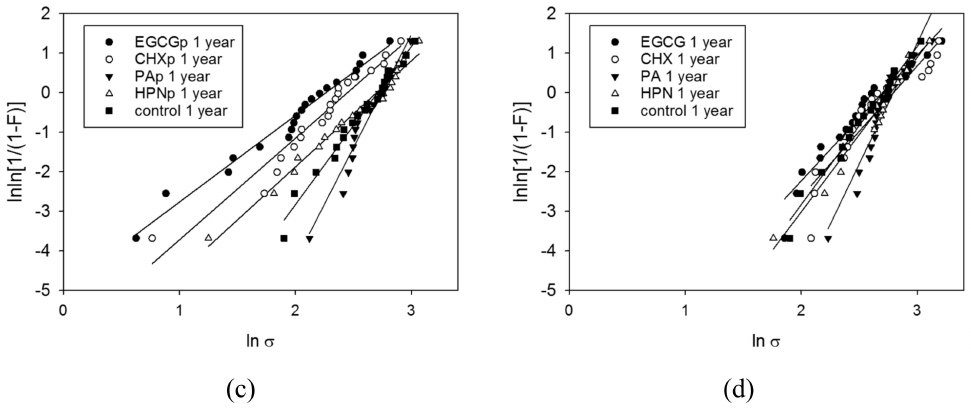
Figure 4. Example of Weibull graphs for the shortest (one week) ( a , b ) and longest (one year) ( c , d ) immersion durations and both antioxidant application protocols: ( a ) one week, primer; ( b ) one week, solution; ( c ) one year, primer; and ( d ) one year,